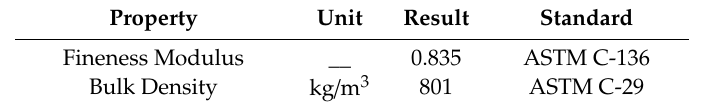
Table 3. Basic physical properties of waste carbon black.